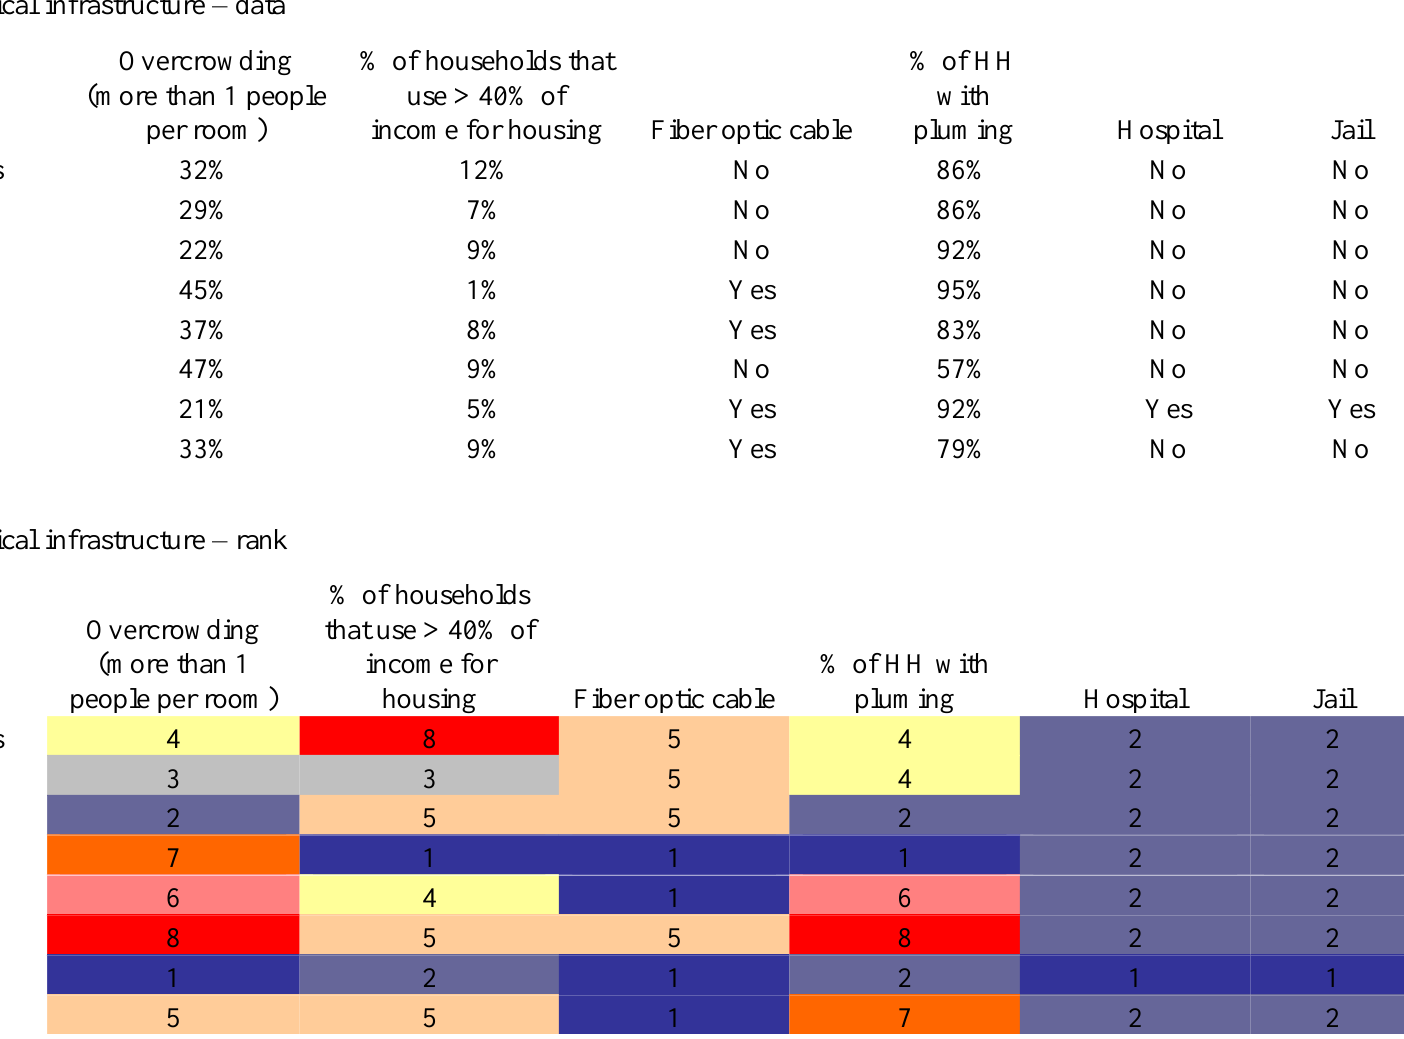
Table A2.7 Human capital –